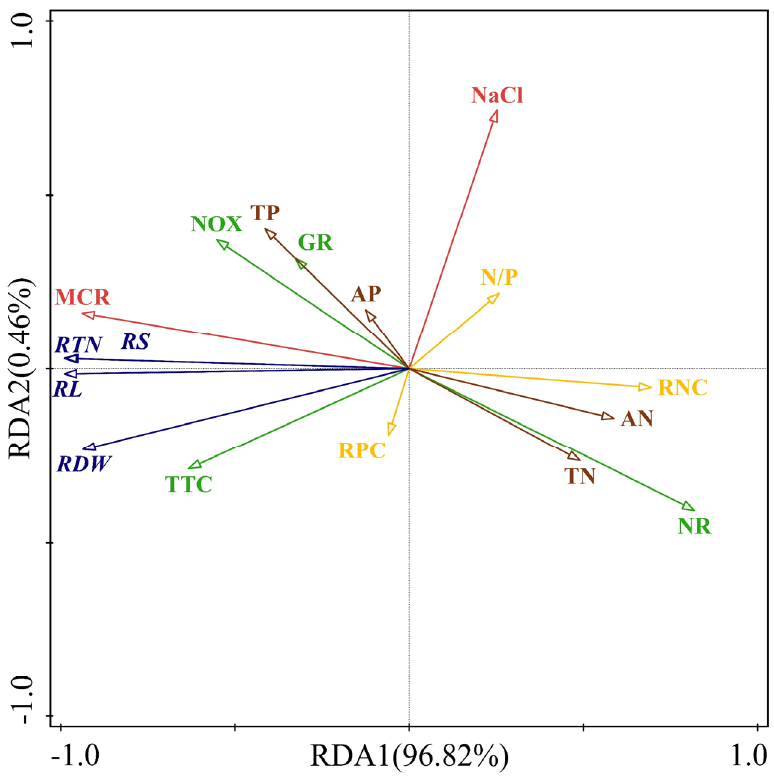
Figure 6. Redundant analysis of NaCl levels, mycorrhizal colonization rate, root morphologies, root nutrient contents, root physiological properties, and soil nutrient contents. Angles and lengths of arrows indicate direction and strength of the relationship of the above indicators. Abbreviations: NaCl, NaCl level; MCR, mycorrhizal colonization rate; AN, soil alkali − hydrolyzable nitrogen; TN, soil total nitrogen; AP, soil available phosphorus; TP, soil total phosphorus; NR, nitrate reductase activity; TTC, root activity; NOX, niacinamide adenine dinucleotide oxidase activity; GR, glutathione reductase activity; RNC, root nitrogen content; RPC, root phosphorus content; N/P, root nitrogen to phosphorus ratio; RDW, root dry weight; RL, root length; RS, root surface area; RTN, root tip number.